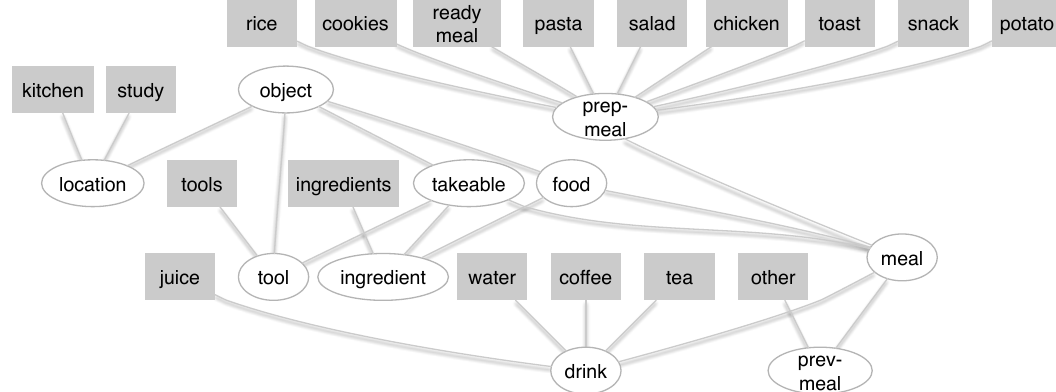
Figure 7. The relevant elements in the environment represented as hierarchy. Rectangles show objects; ellipses describe the object types; and arrows indicate the hierarchy or “is-a” relation (the arrow points to the father class). Figure adapted from [38].